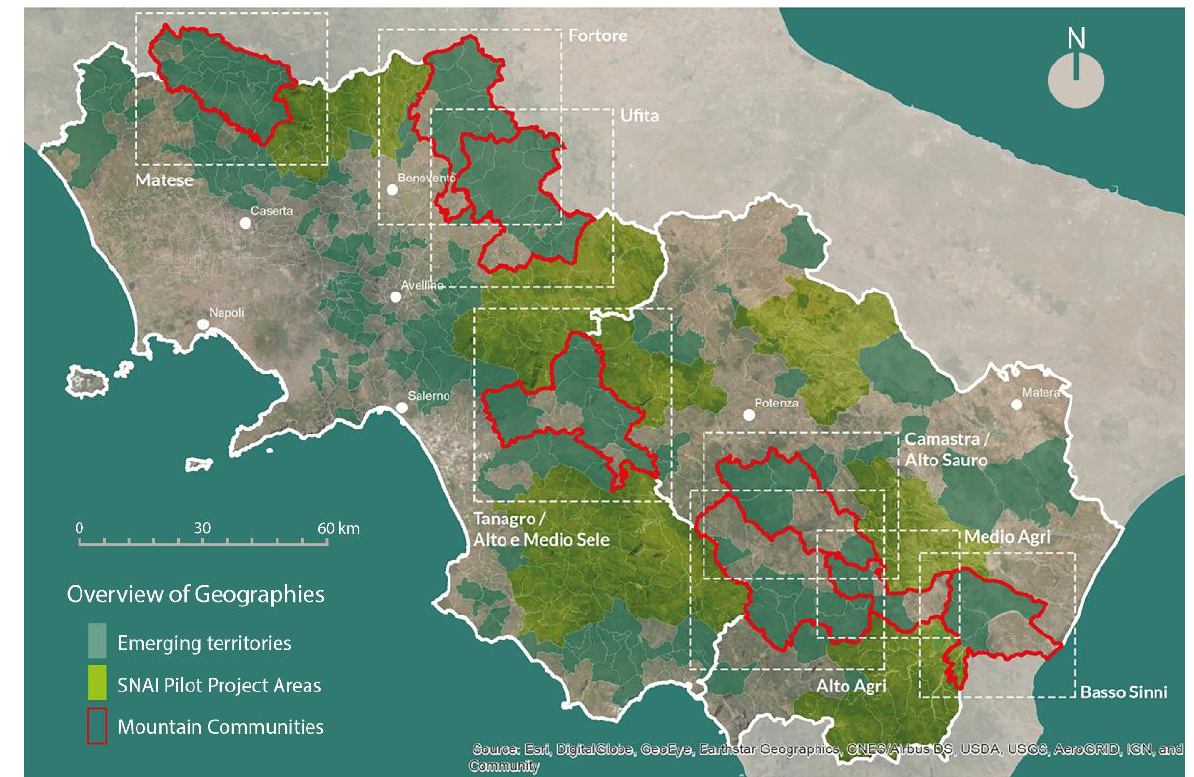
Figure 1. The inland areas of Campania and Basilicata identified from the analyses © Figure RI.P.R.O.VA.RE Project.